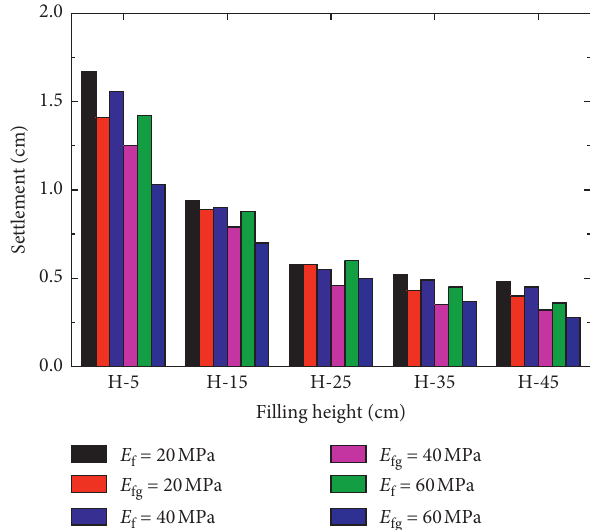
Figure 18: Comparison of the settlement between unreinforced and reinforced conditions.